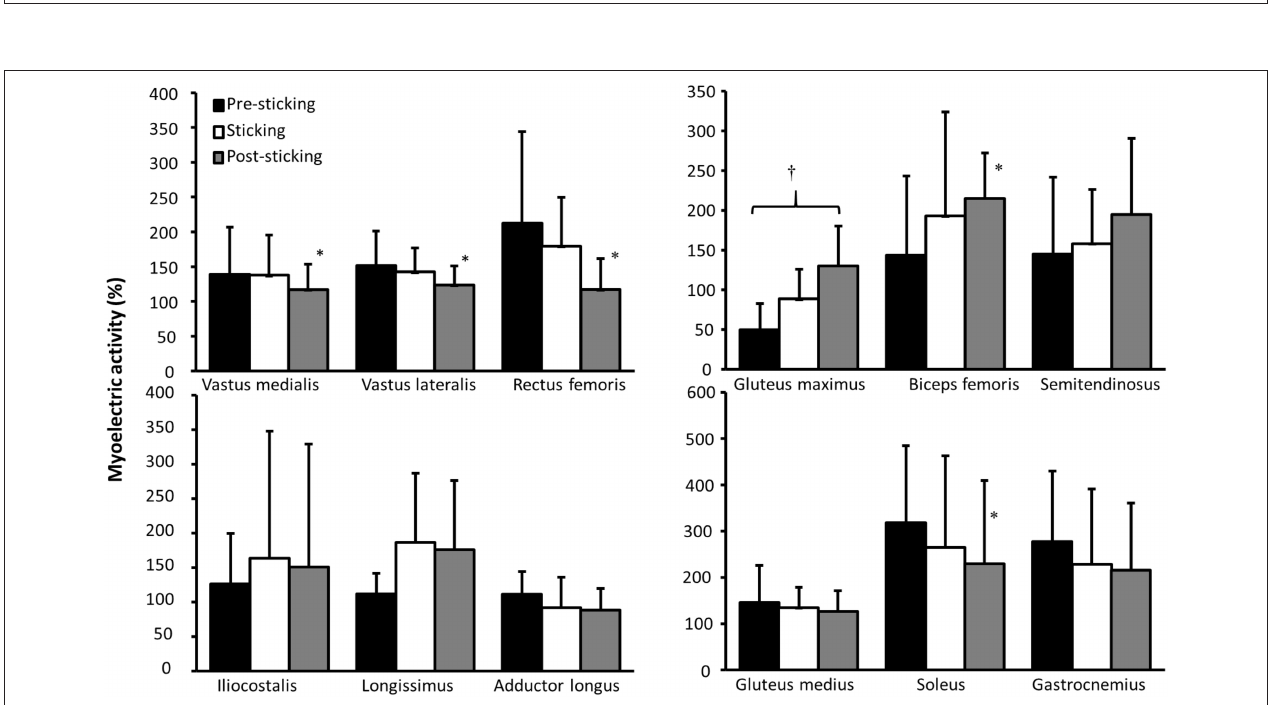
FIGURE 5 | Mean ± SD normalized myoelectric activity for the erector spinae iliocostalis, erector spinae longissimus, adductor longus, gluteus maximus, biceps femoris, semitendinosus, vastus medialis, vastus lateralis, rectus femoris, gluteus medius, soleus, and gastrocnemius in the pre-sticking, sticking, and post-sticking regions during the last repetition in 3-RM back squats. † indicates a significant difference between these two regions on a p ≤ 0.05 level. * indicates a significant difference between this region and all other regions on a p ≤ 0.05 level.